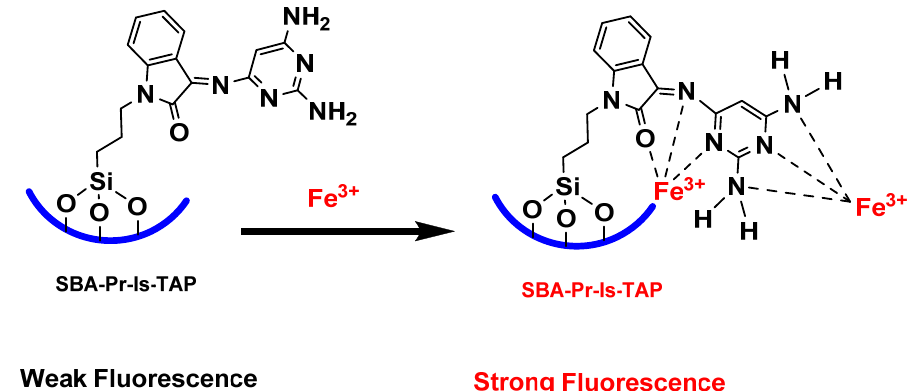
Scheme 2. Suggested bonding mode of SBA-Pr-Is-TAP with Fe³ ⁺ .